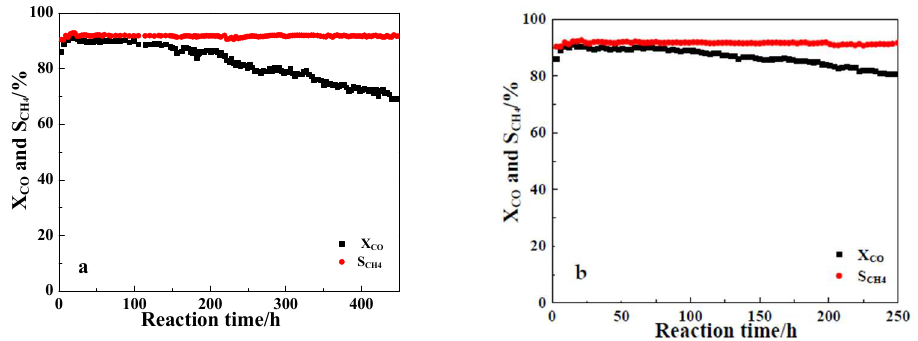
Figure 1. CO conversion and CH 4 selectivity of fresh catalyst ( a ) and refreshed catalyst ( b ) in slurry-bed reactor.